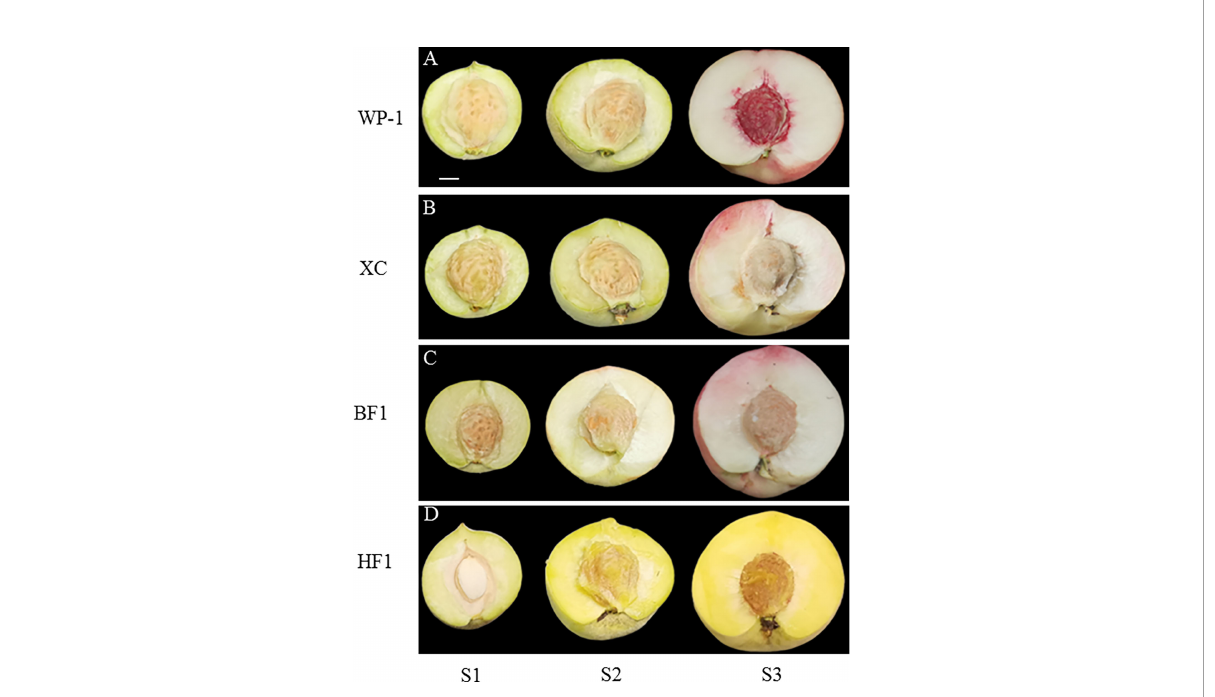
FIGURE 1 Phenotypes of Chang Song White Peach, ‘ Xia Cui ’ and their hybrid F1 generations at different fruit development stages. (A) Chang Song White Peach (WP-1). (B) ‘ Xia Cui ’ (XC). (C) White- fl eshed peachs F1 generation (BF1). (D) Yellow- fl eshed peachs F1 generation (HF1). S1 presents core- hardening stage. S2 stands for color-transformation stage. S3 representing mature. Bars = 1cm.